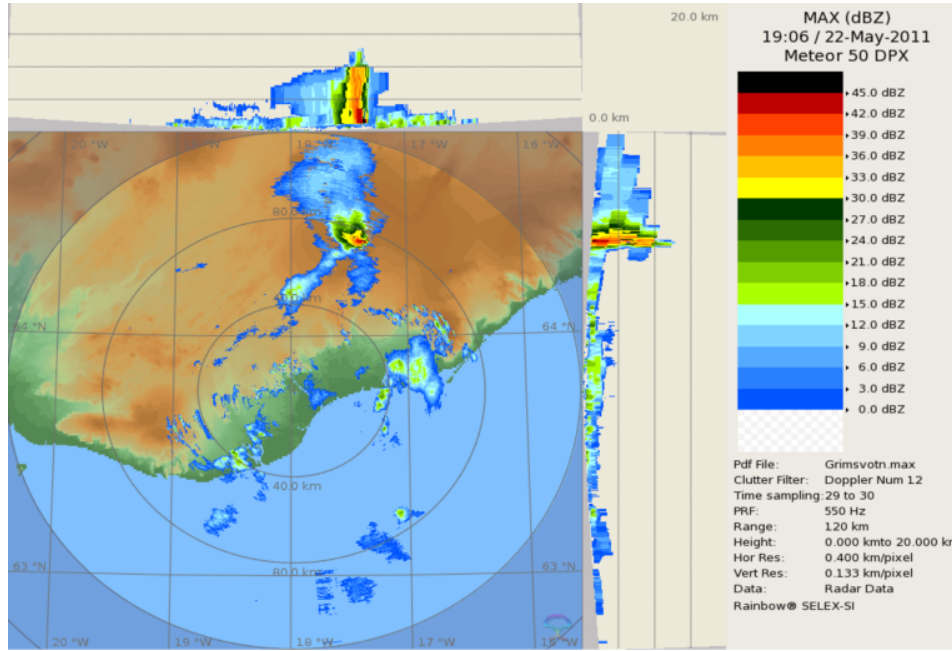
Figure 16. Radar reflectivity plot displaying ash dispersal during the Grímsvötn 2011 eruption in